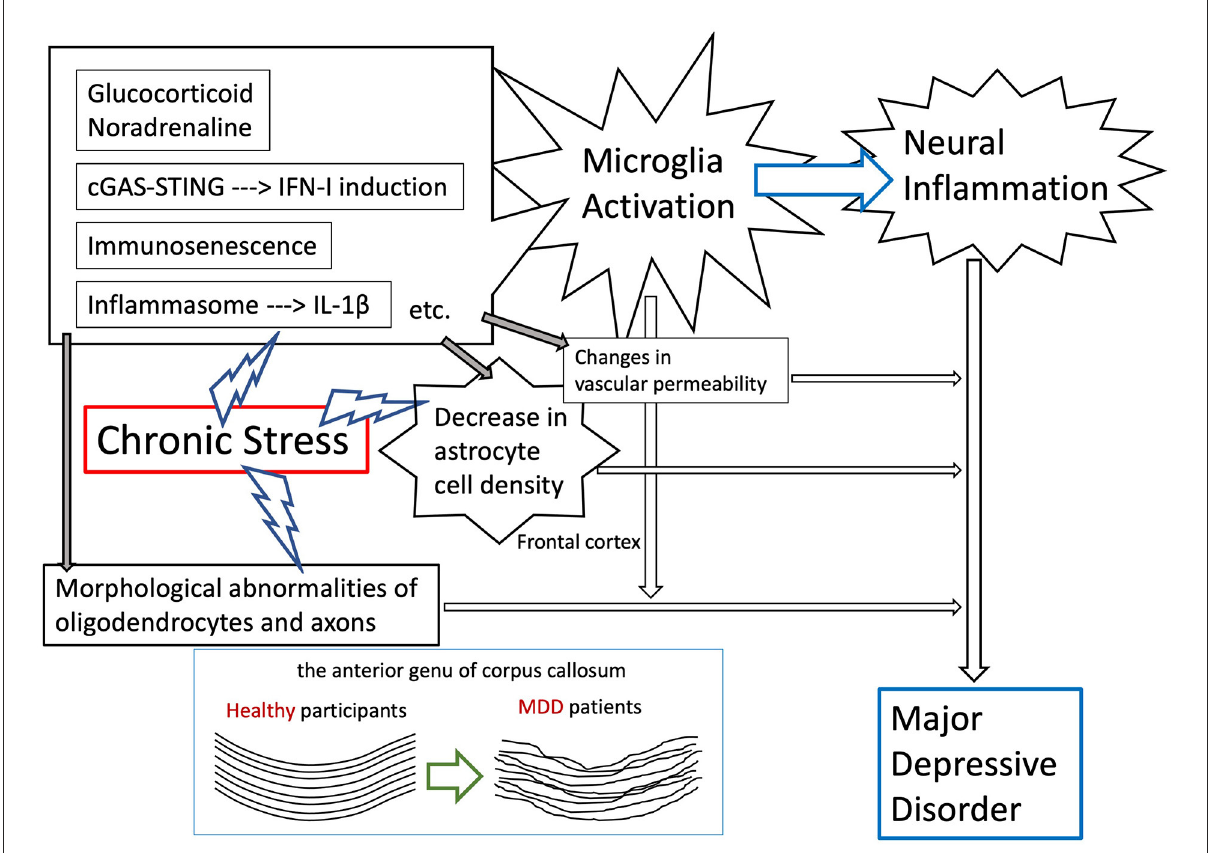
FIGURE1 Expected mechanisms of the onset of MDD by the effects of intracerebral inflammation due to environmental stress